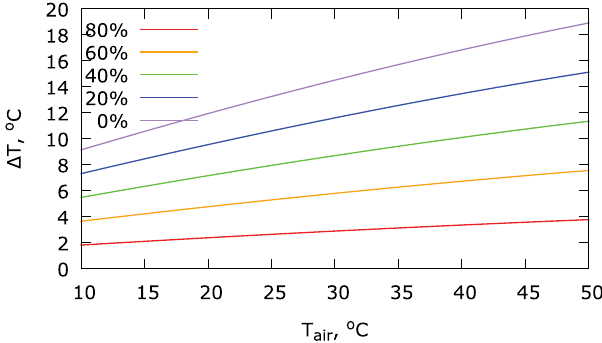
Fig. 5. The temperature difference D T between the cooling jug and the exterior air as given by equation (6), plotted against the temperature of the exterior air T air . Situations corresponding to different humidities f air are shown in different